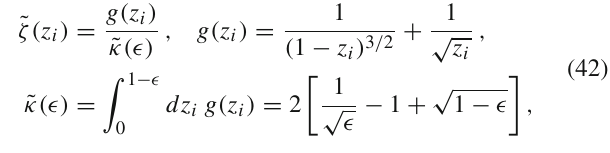
Fig. 3 Comparisons of the inclusive x distributions from the Monte Carlo program MINCAS for the x and k evolution of Eq. (19) with the x -only evolution of Eq. (21), for the evolution time values: t = 0 . 1, 1, 2 and